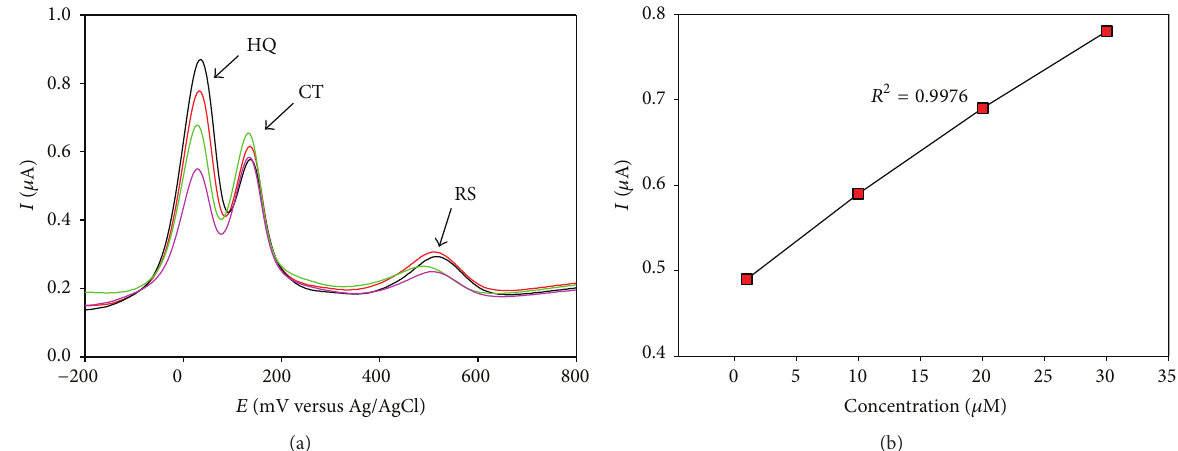
Figure 8: (a) Differential pulse voltammogram (DPV) HQ in the presence of CT and RS PGA modified GCE in PBS. (b) Calibration curve for the quantitative determination of HQ in ternary mixture with CT and